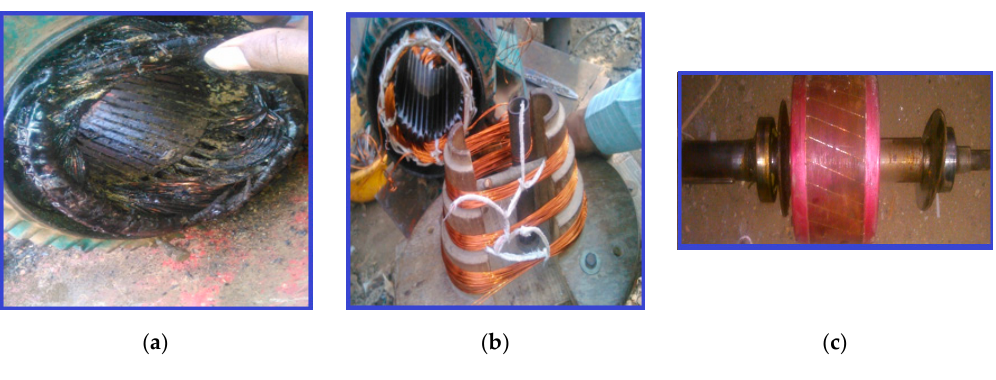
Figure 6. ( a ) Old scrap motor. ( b ) Redesigned winding arrangement for the proposed multifunctional motor. ( c ) Squirrel cage rotor (rotor of the old machine).